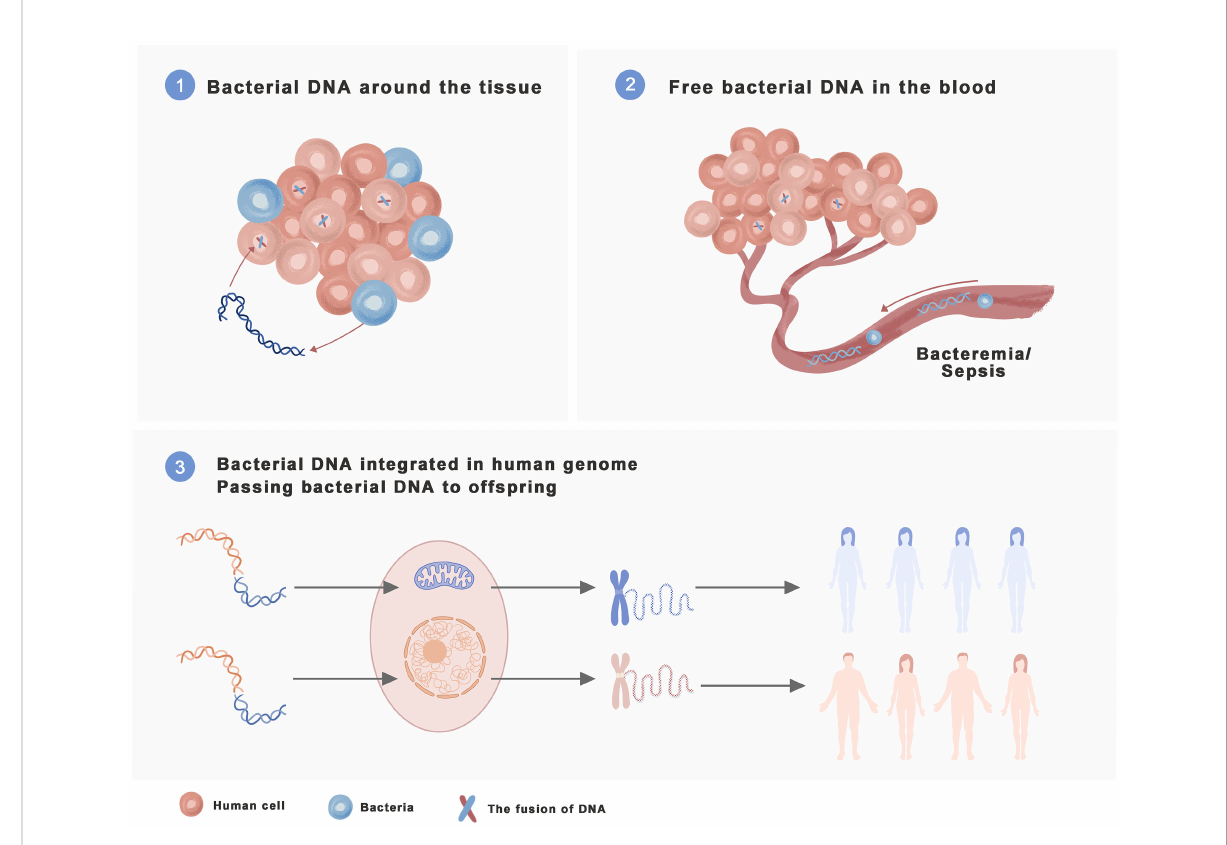
FIGURE 3 Three Sources of bacterial DNA in human cancers. ① Organs that are direct contact with the outside world, such as the colorectal area and lung, are full of bacteria, and tissue cells are almost bathed in bacteria. The DNA excreted by the bacteria surrounding the tissue can enter receptive human cells, resulting in gene integration. ② Breast cancer, bone cancer and other organs that are not exposed to the outside world usually cannot come into direct contact with a large number of bacteria. However, when the body is infected with bacteremia, septicemia, etc., they can come into contact with bacteria and their DNA in the blood circulation. The greater the demand for blood supply, the greater the chance of contact. Human cells come into contact with and absorb bacterial DNA, resulting in gene integration. When bacterial DNA is integrated with the human genome, it will persist in human cells without incident. Genes are vertically inherited and will be passed on to future generations. This inheritance may be the cause of endogenous bacterial DNA in the human